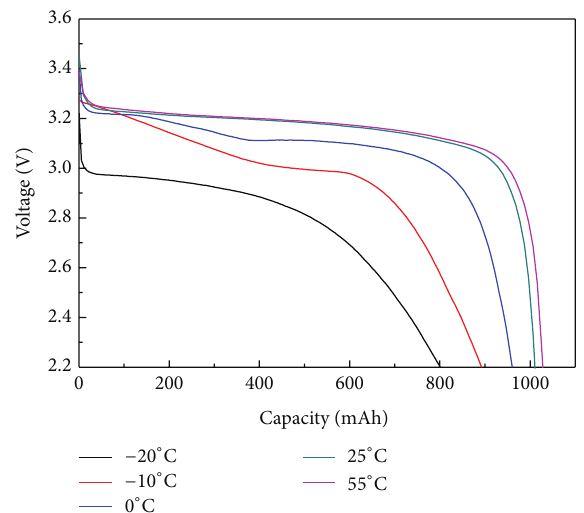
Figure 6: The high and low temperature